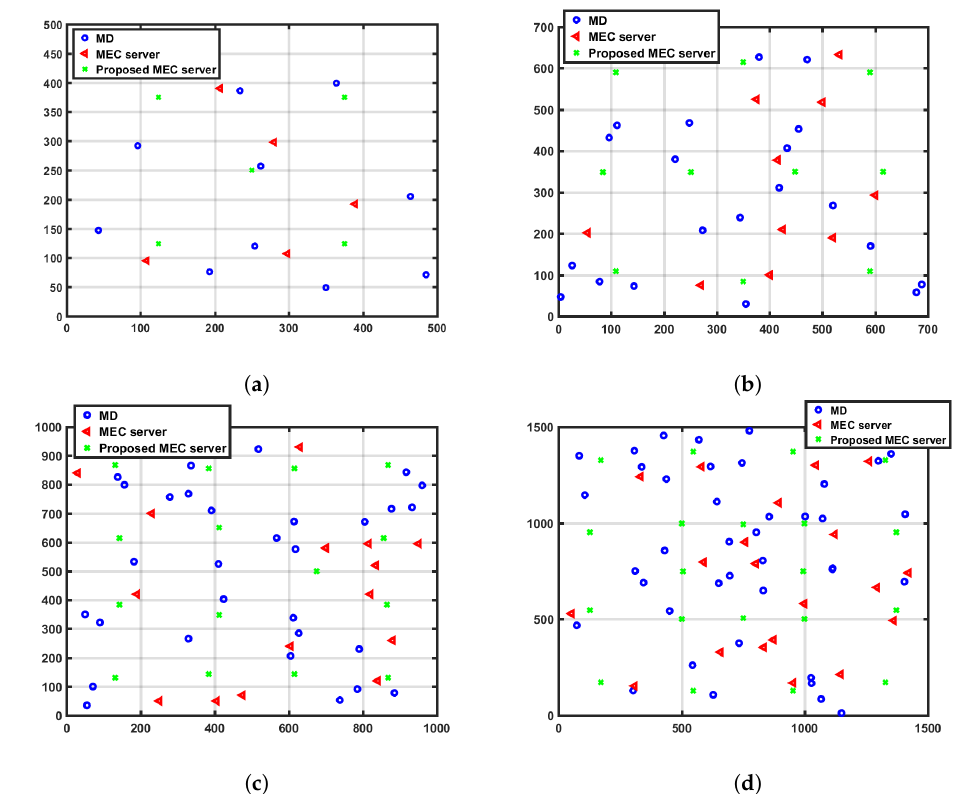
Figure 3. The proposed distribution of MECs in four different topology structures. ( a ) First Topology Structure in 500 × 500 m; ( b ) Second Topology Structure in 700 × 700 m; ( c ) Third Topology Structure in 1000 × 1000 m; ( d ) Fourth Topology Structure in 1500 × 1500